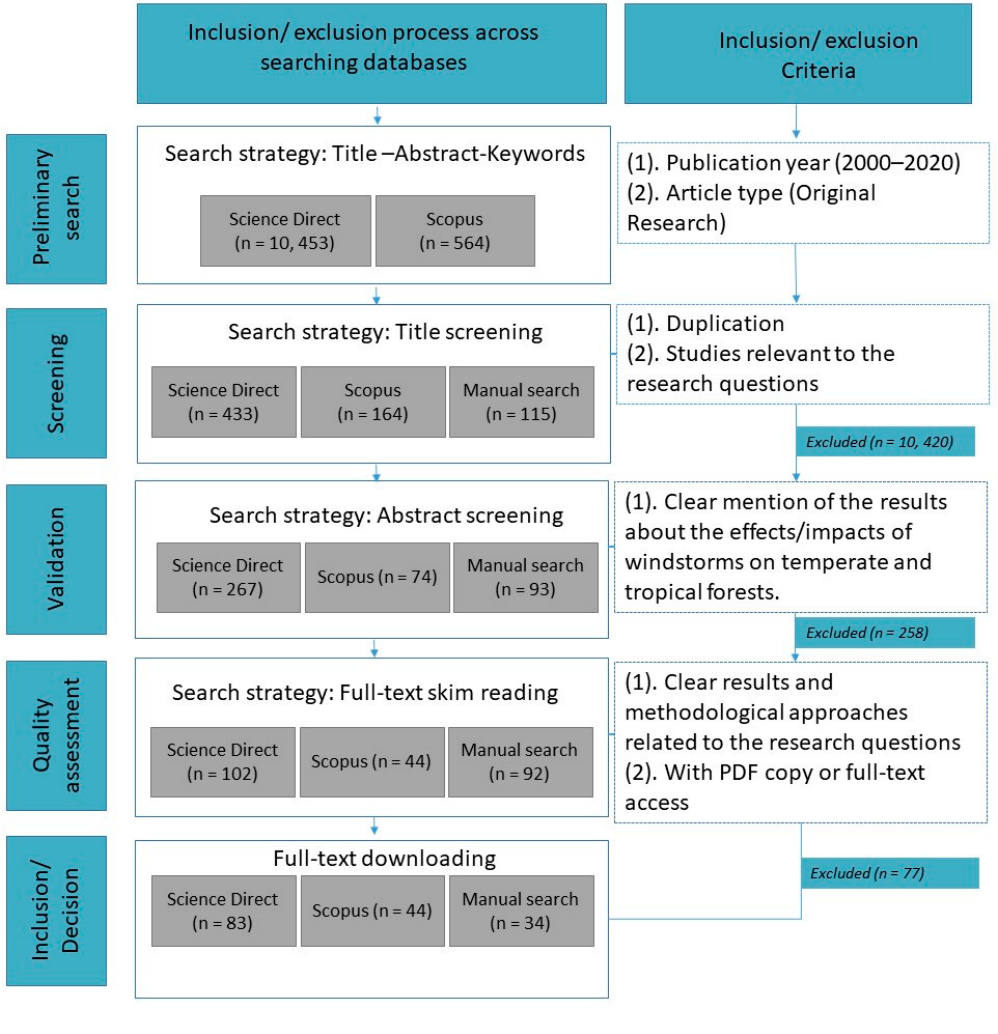
Figure 6. The flow diagram for database and manual search of publications used for the present systematic literature review.